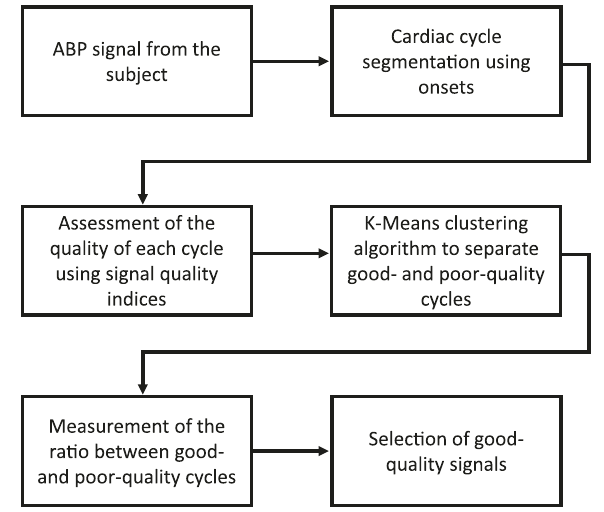
Fig. 4 Signal quality assessment algorithm. This algorithm was applied for discarding low-quality arterial blood pressure signals.